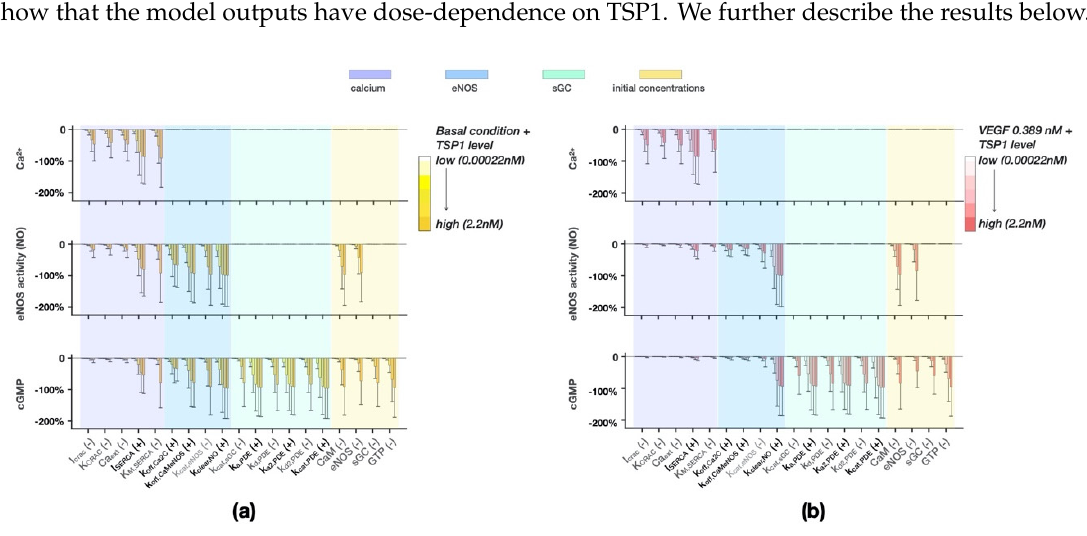
Figure 5. ( a ) Perturbations that are significantly effective in reducing the model output area under curve (AUC) levels by at least 20% compared to the baseline level. VEGF concentration is 0.0003 nM. ( b ) Effects of the same set of perturbations when VEGF is 0.389 nM. Bars: mean percent difference between perturbations and baseline level using the 19 sets of best fit parameter values with six TSP1 levels (0.0002–2.2 nM). Error bars: standard deviation of 19 sets of simulations. X-axis labels with (+) sign with black font: parameter was increased using the left panel Hill function in Figure 3; (-) sign with gray font: parameter was decreased using the right panel Hill function in Figure 3.